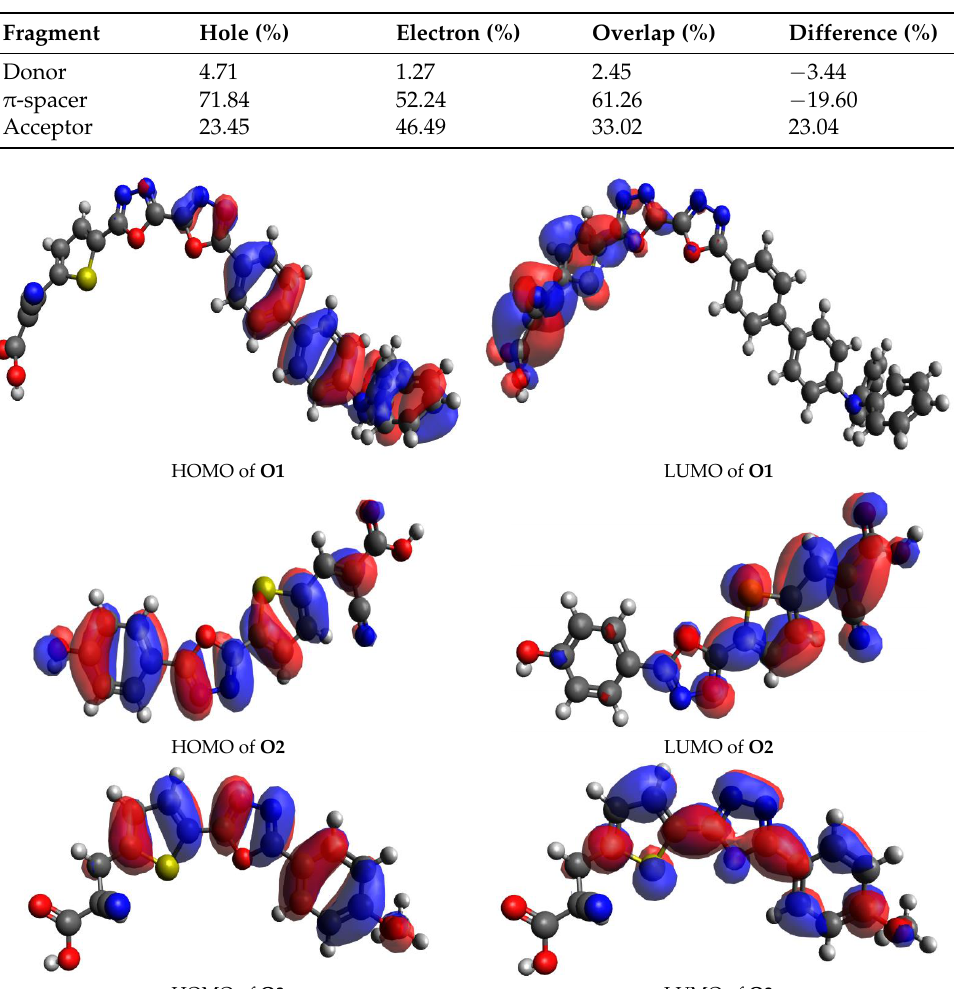
Table 10. Fragment contribution to electron–hole overlap in O7 .